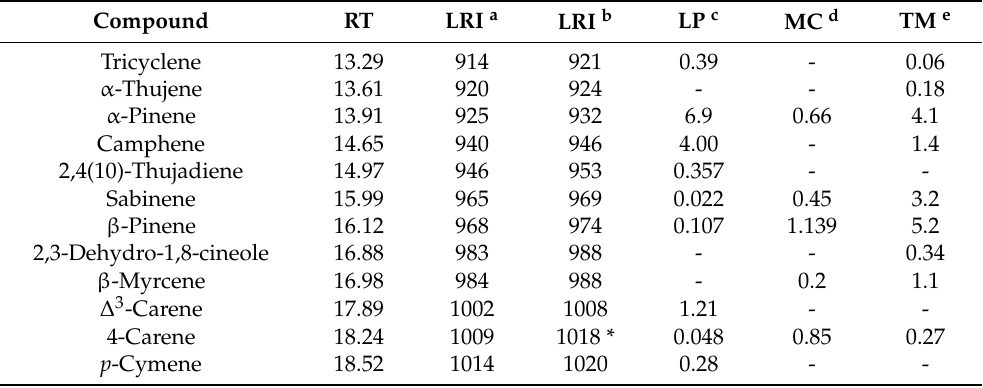
Table 1. Chemical composition of L. pedunculata , M. cervina , and T. mastichina OEs from C ô a Valley, Northeastern